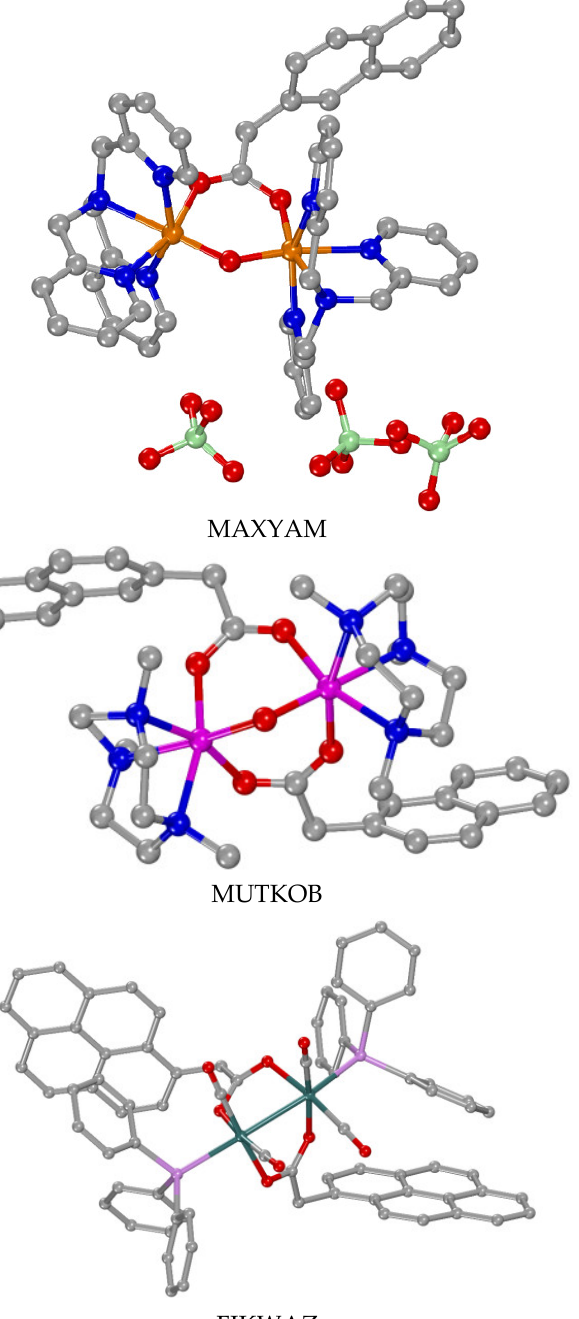
Figure 18. Molecular structures of selected complexes bearing only bidentate bridging (µ–Ο,Ο’) ligands. MAXYAM = [Fe 2 (µ 2 –O)(µ 2 –N2A–O,O′)(TPA) 2 ](ClO 4 ) 3 [65]; LANDUB = [Cu 2 (µ 2 –N2A–O,O′) 4 (DMF) 2 ] [68]; MUTKOB = [Zn 2 (µ 2 –OH)(µ 2 –N2A–O,O′) 2 (TACN–Me 3 ) 2 ](ClO 4 ) [66]; RANHIA = [Cu 2 (µ 2 –NAP–O,O′) 4 (3pic) 2 ] [48]; YISFIR = [Ru 2 (µ 2 –N2A–O,O′) 4 (H 2 O) 2 ](PF 6 )·THF [71] and FIKWAZ = [Ru 2 (µ 2 –PYA–O,O′) 2 (CO) 4 (PPh 3 ) 2 ] [35]. Hydrogen atoms, disordered atoms and solvate molecules are omitted for clarity reasons. Color code for atoms: C: gray, O: red, N: blue, Co: orange; Cu: green; Cl: light green; Zn: magenta; P: pink and Ru: petrol green. The figures of the structures were adapted from the corresponding references.